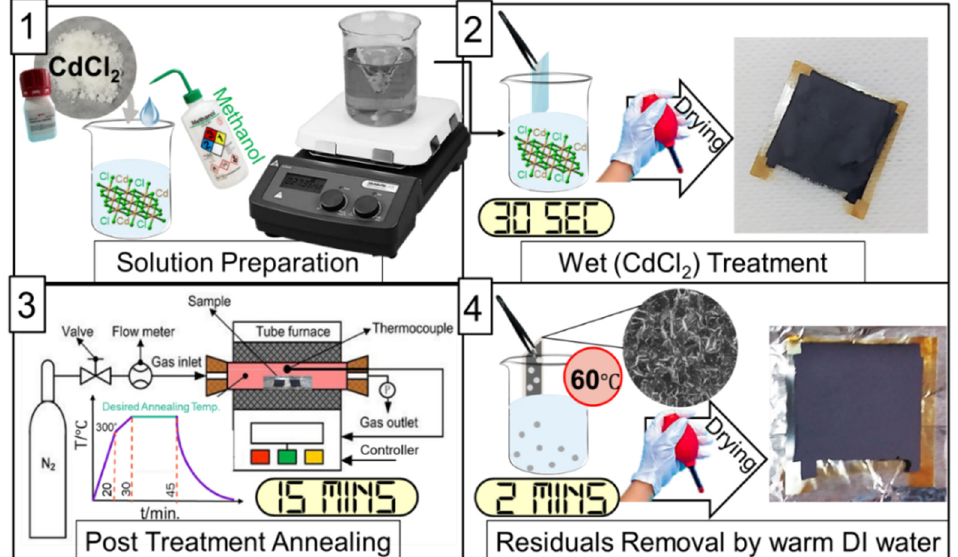
Figure 3. Schematic illustration of the sequential CdCl 2 treatment, ( 1 ) Solution preparation, ( 2 ) Wet CdCl 2 treatment, ( 3 ) Post treatment annealing, ( 4 ) Residuals removal by warm DI water.